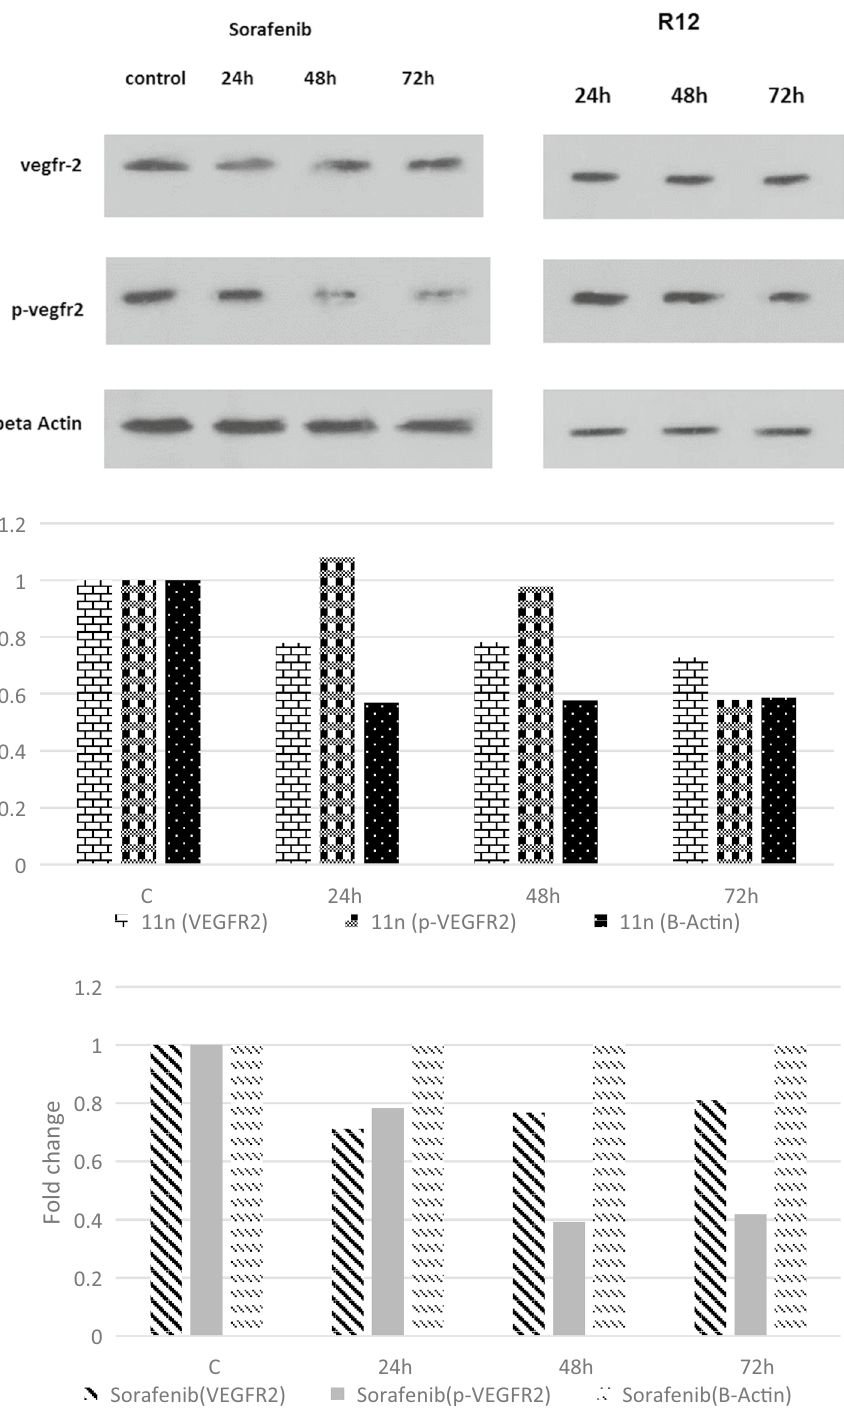
Figure 7. Representative western blot and bar chart analysis showing expression of VEGFR-2, P-VEGFR-2 against Sorafenib, 11n (samples were run on a separate PVDF for detecting each